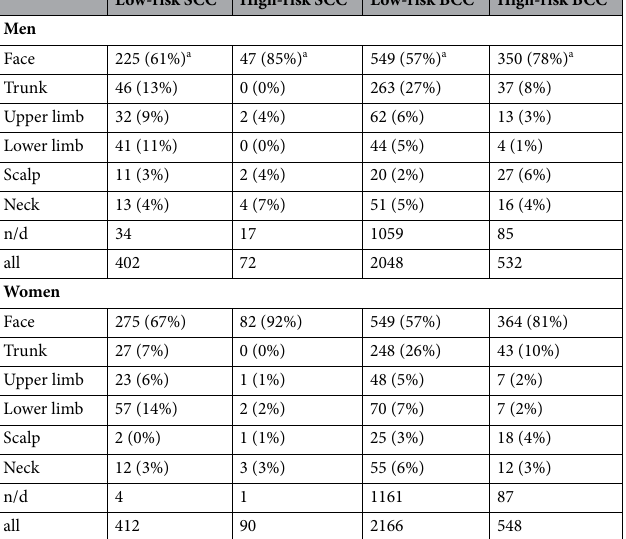
Table 1. BCC and SCC subtypes sites depending on the sex of the patients. Data are presented as n (%). n/d not defined, BCC basal cell carcinoma, SCC squamous cell carcinoma. a High-risk BCCs and SCCs were most common on the face ( p <